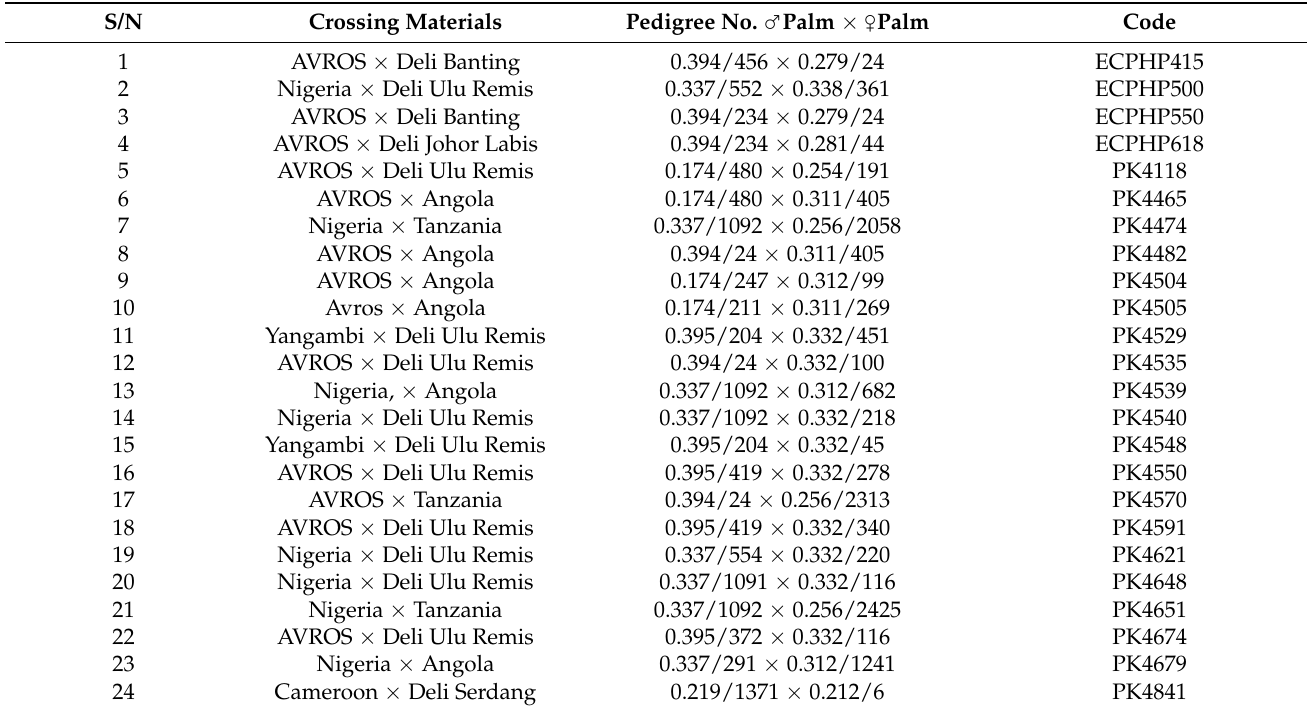
Table 1. List of dura × pisifera (D × P) hybrids used in this